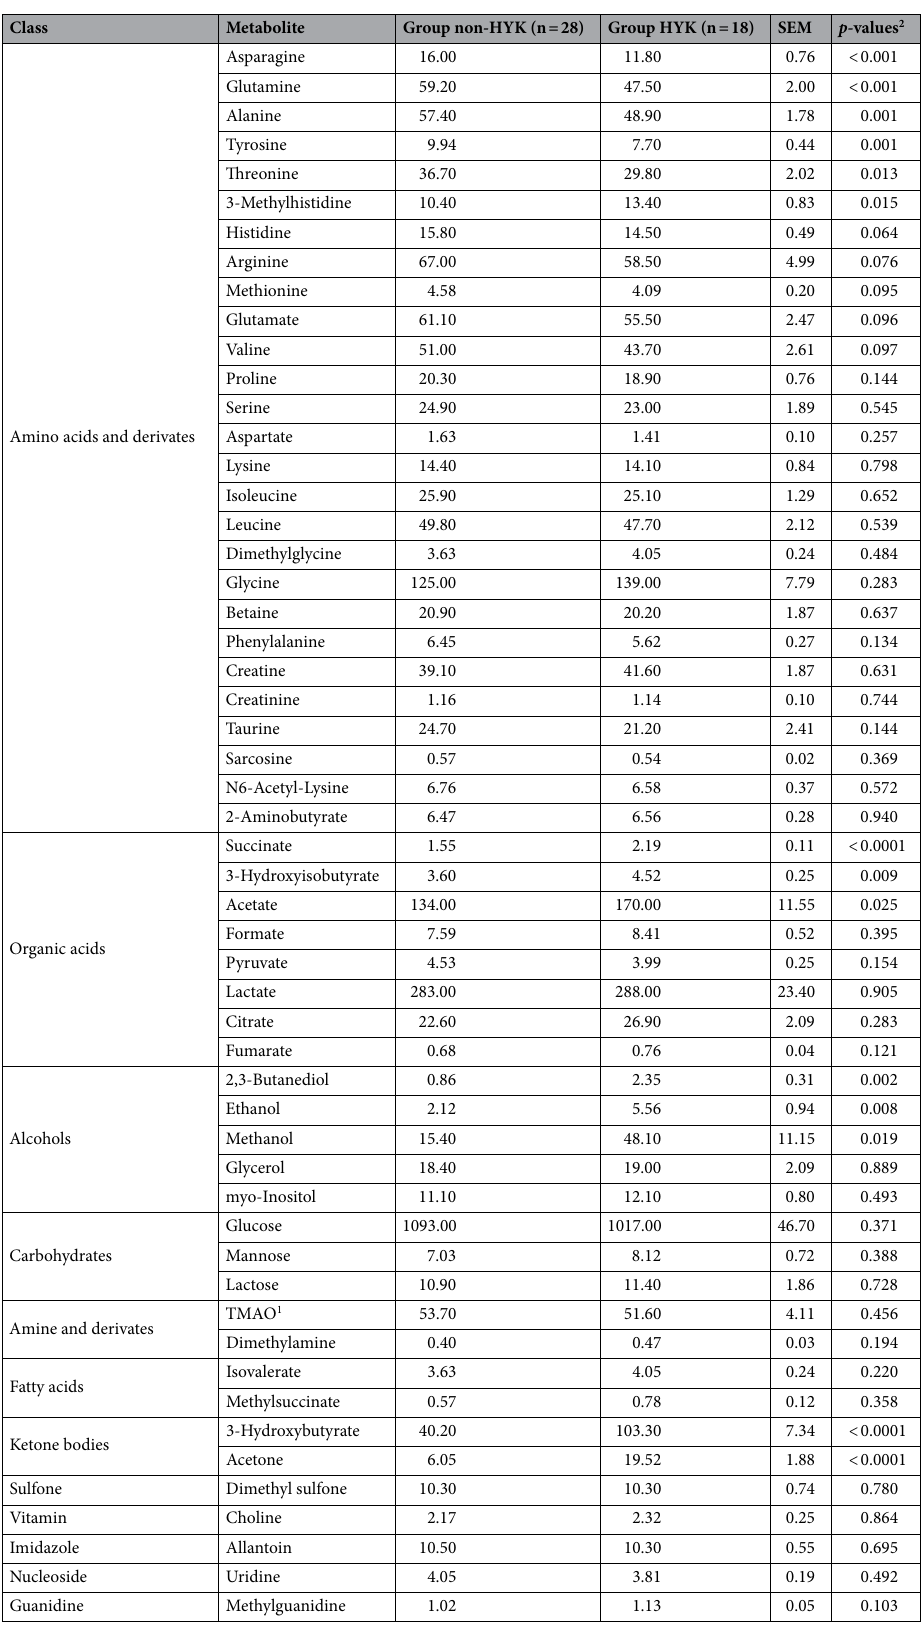
Table 2. Mean values and standard error of means (SEM) of identified metabolites (μmol/L) within the two groups (group Non-HYK with BHB < 0.80 mmol/L and group HYK with BHB ≥ 0.80 mmol/L). 1 Trimethylamine-N-oxide. 2 P -values corrected with Bonferroni